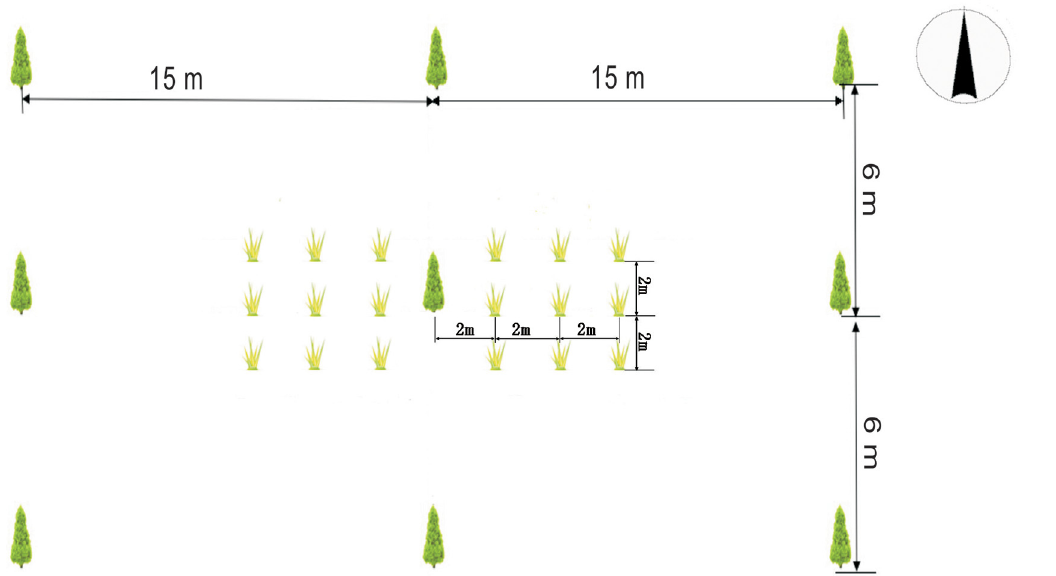
Fig 1. Sampling locations from the tree row into the cropping alley. The crop like symbol refer to sample